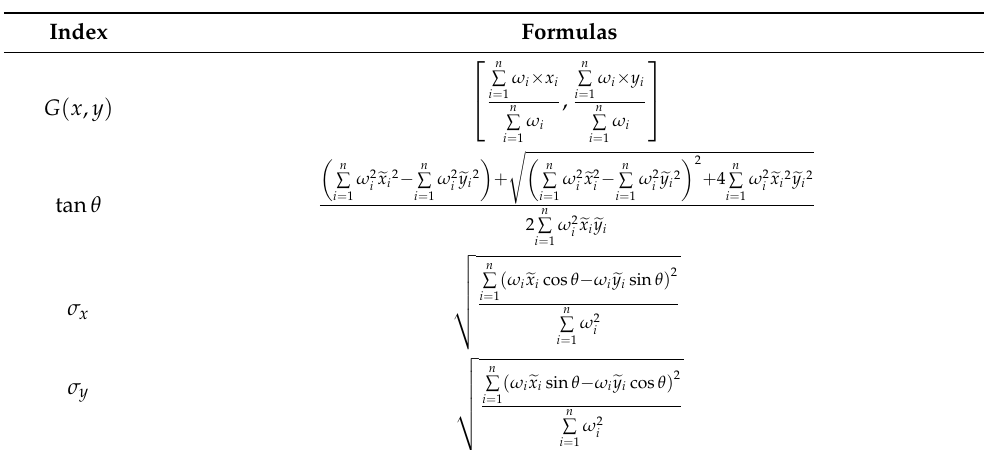
Table 1. Gravity standard deviational ellipse